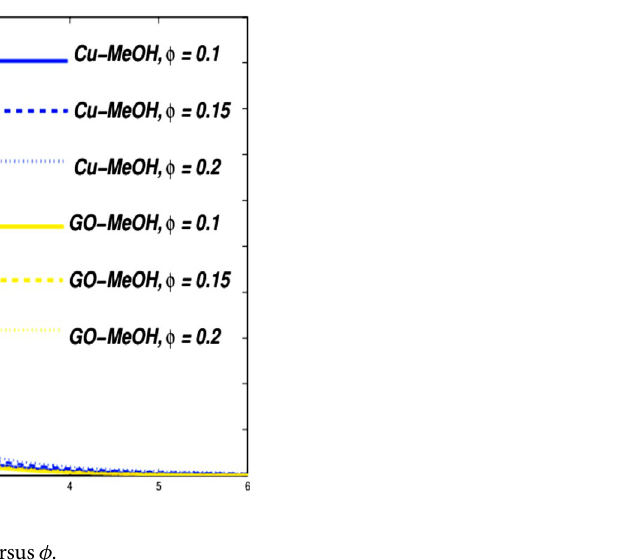
Figure 11. Temperature variation versus φ